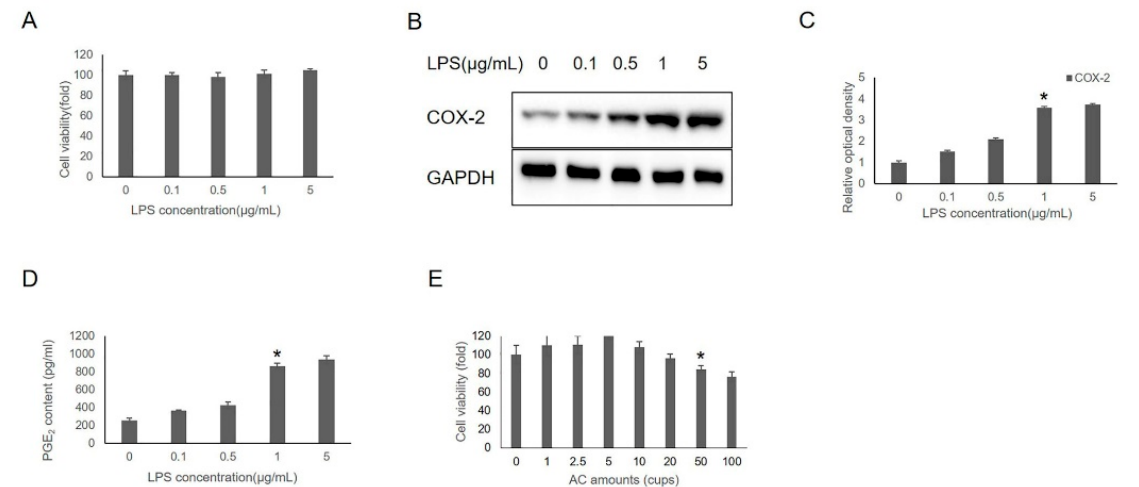
Figure 1. Effects of LPS and AC on IHOKs. MTT(3-(4,5-dimethylthiazol-2-yl)-2,5-diphenyltetrazolium bromide) assay was used to assess the cell viability of IHOKs after treatment with different LPS concentrations or AC amounts. ( A ) IHOKs were treated with 0–5 µ g/mL LPS for 24 h. ( B ) COX-2 levels in 0–5 µ g/mL LPS-induced IHOKs were detected by Western blot analysis. ( C ) Relative optical density was measured using Image J software. ( D ) The released PGE 2 levels in 0–5 µ g/mL LPS-induced IHOKs were detected using the prostaglandin E 2 assay kit. ( E ) IHOKs were treated with 0–100 cups of AC for 24 h. * p -value < 0.05 vs. control.